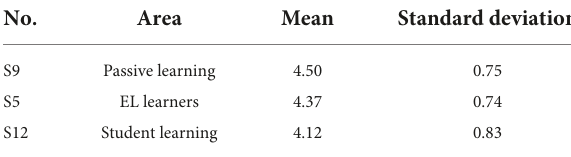
TABLE 7 Teachers’ perceptions associated with learning in the